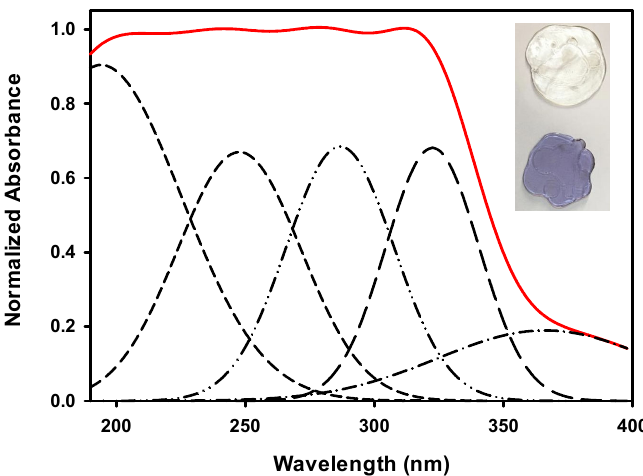
Figure 4. Deconvolution of normalized absorbance spectra of GR with inset pictures of GRN and GRD samples.